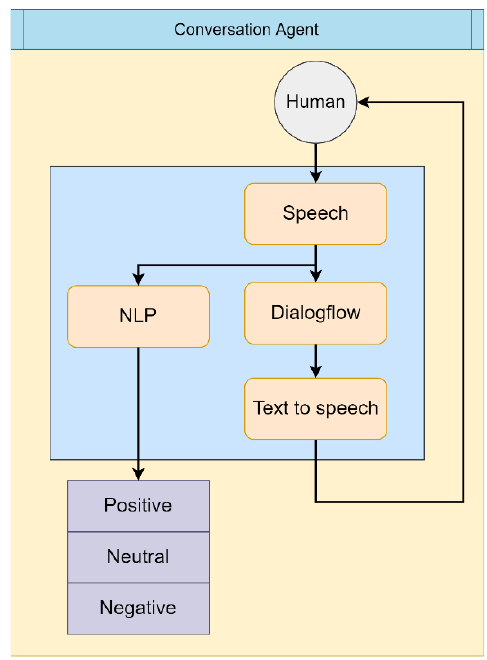
Figure 6. Schematic diagram of event trigger.